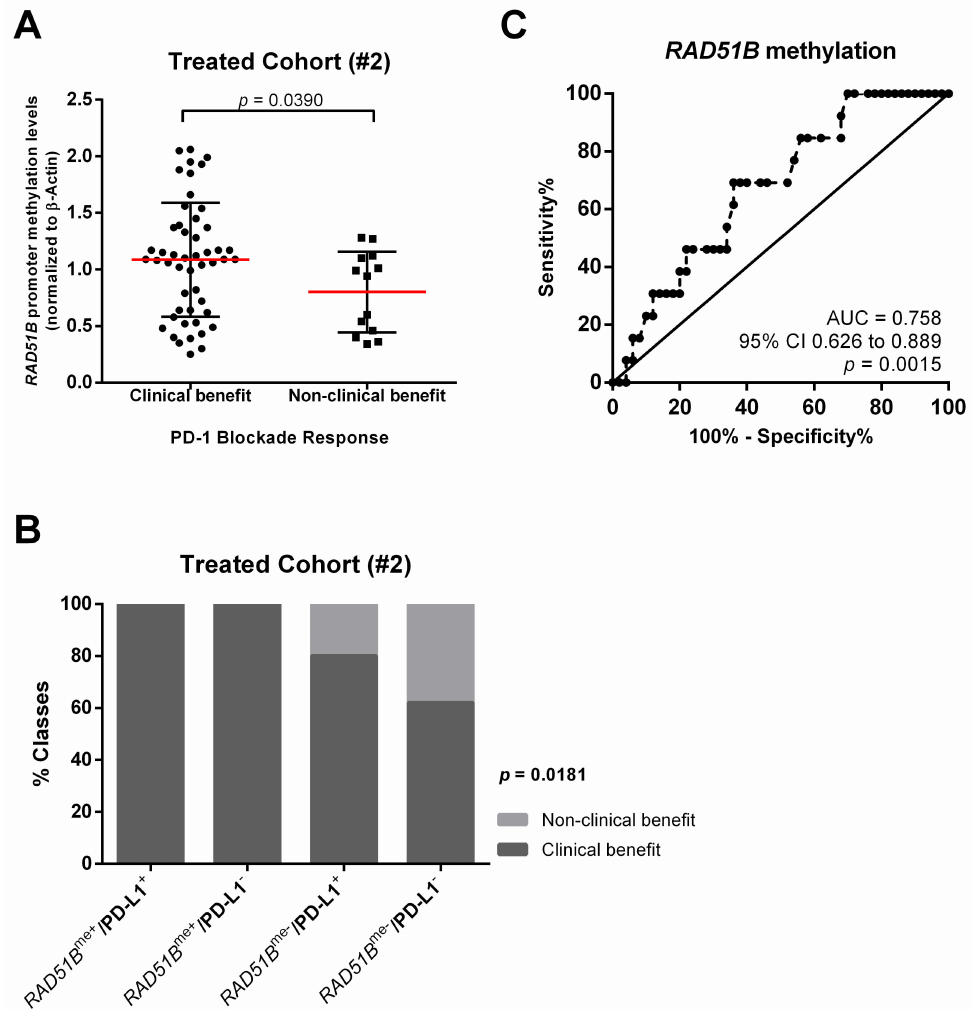
Figure 2. RAD51B me levels and PD-L1 positivity associate with PD-1 blockade clinical benefit. ( A ) Scatter plot representing RAD51B promoter methylation levels distribution obtained by qMSP in patients with and without clinical benefit from immunotherapy. Mann–Whitney U-test. Red horizontal line represents the median methylation levels; ( B ) Contingency graph displaying the percentage of patients with and without PD-1 blockade clinical benefit, according to RAD51B promoter methylation and PD-L1 status. Chi-square test. RAD51B me were considered positive when promoter methylation levels > P75; ( C ) Receiver operator characteristic (ROC) curve for discrimination between patients with and without clinical benefit from immunotherapy based on RAD51B promoter methylation levels distribution in the Treated Cohort